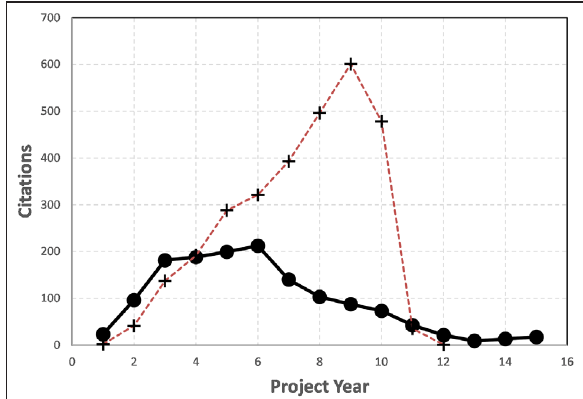
Figure 3: Citation history of the 86 papers for the 22 pub- lished CS programs that generated 1,531 citations (solid line) and the 57 papers from Galaxy Zoo (dotted line), which contributed 2,984